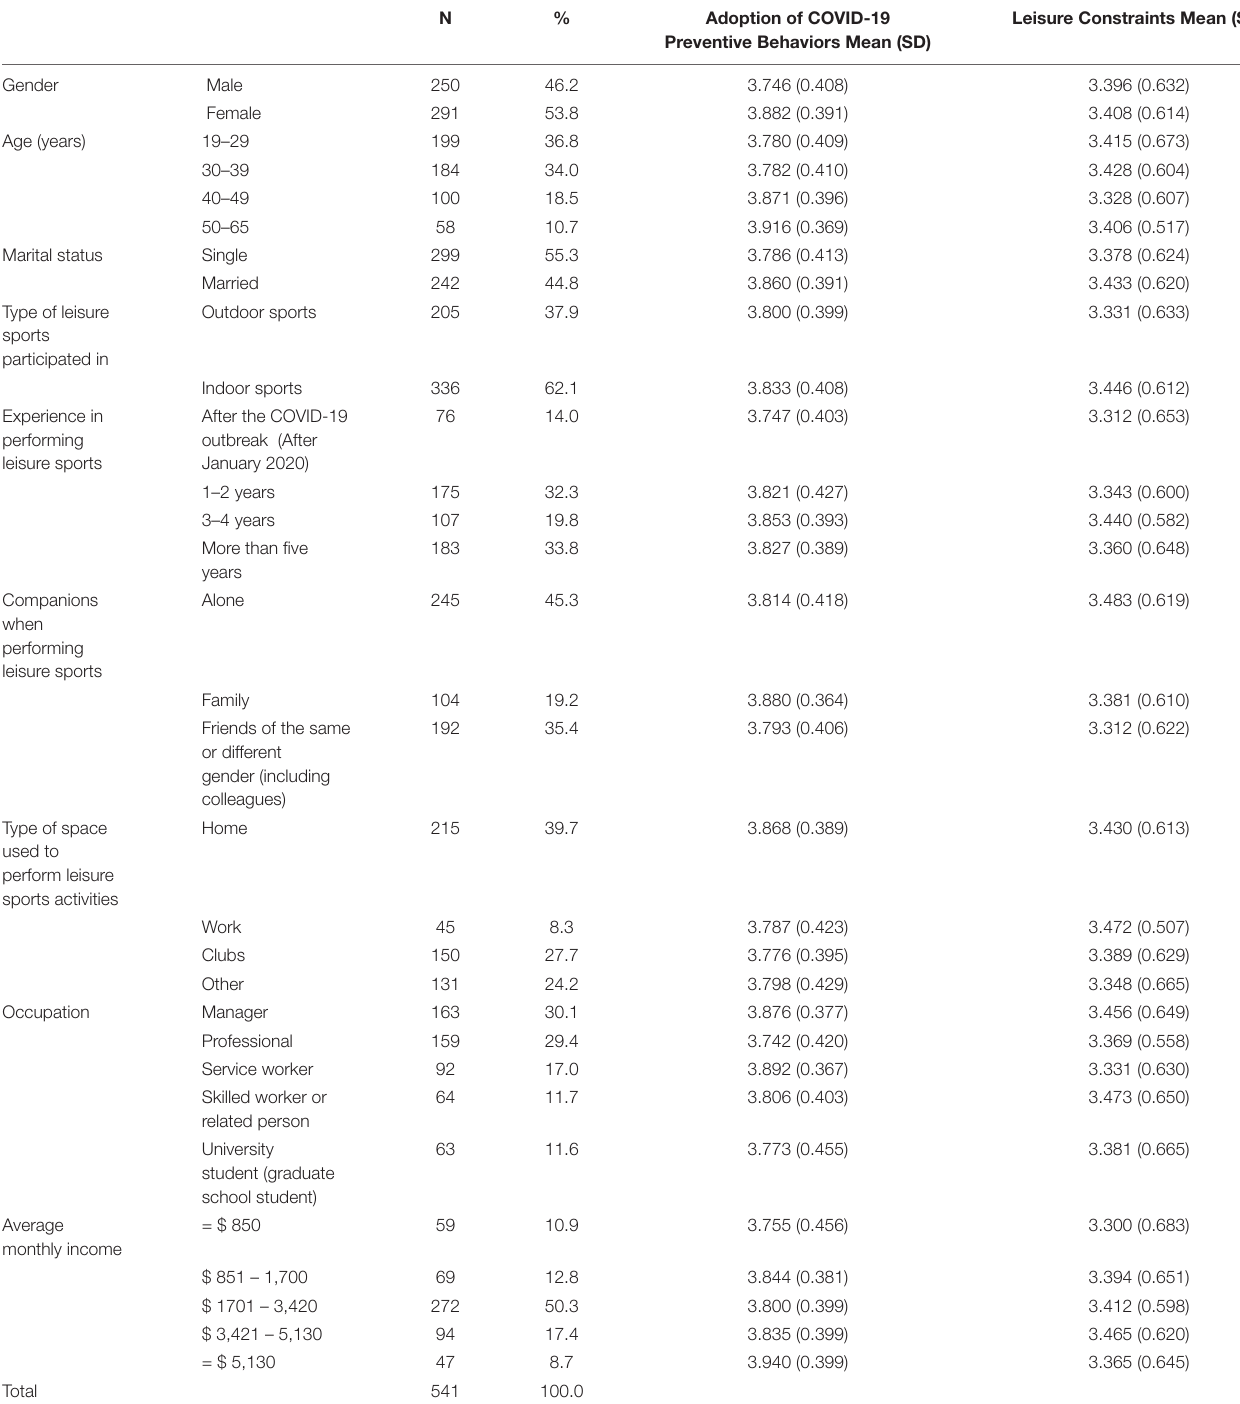
TABLE 1 | Participants’ characteristics, adoption of preventive behaviors, and leisure constraints.